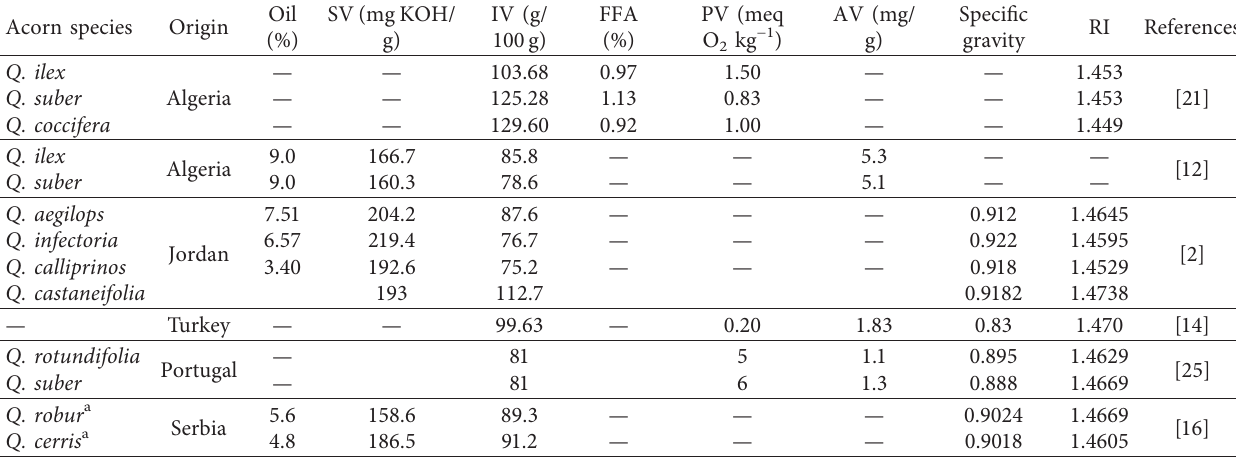
Table 2: Chemical characteristics of oil extracted from acorn